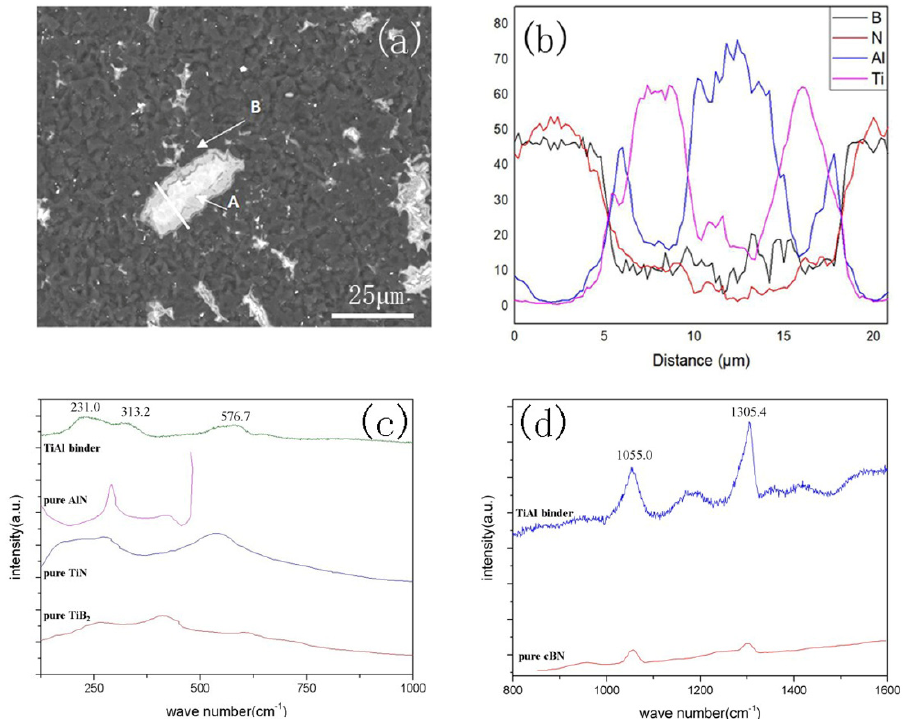
Figure 4. Microstructure and phase analysis of cBN composites: ( a ) 15 µ m, ( b ) EDS of the line in ( a ), ( c ) Raman spectra of point A in ( a ), ( d ) Raman spectra of point B in ( a